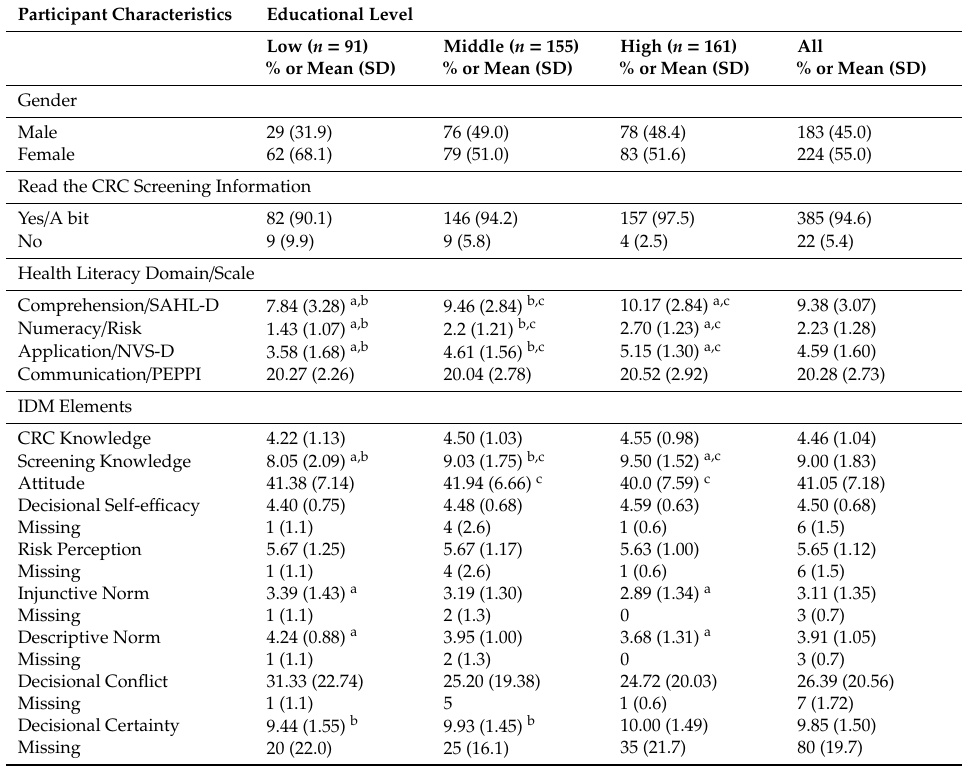
Table 1. Participant characteristics ( n = 407) per educational level (low, middle, and